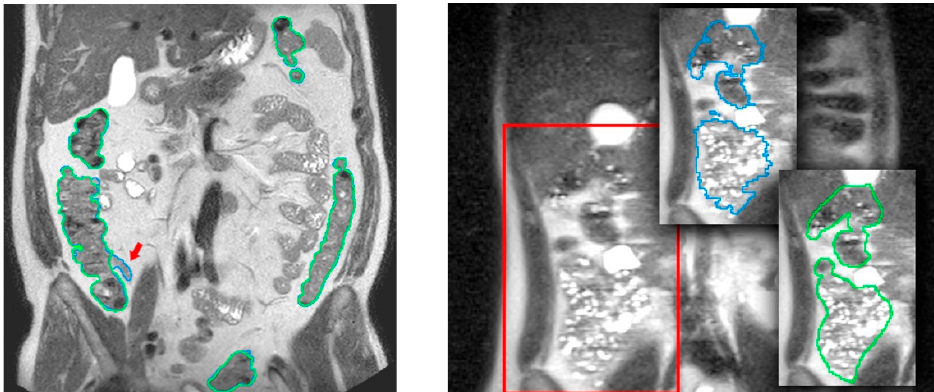
Figure 4. Comparison of segmentation results (in blue) with a ground truth manual colon segmenta- tion (in green) in T2 images. In the left image, the red arrow marks a small ileum region wrongly assigned to colon by the automatic algorithm. In the right image, a highly challenging area even for the specialists (outlined in red) is shown. Courtesy of [7].